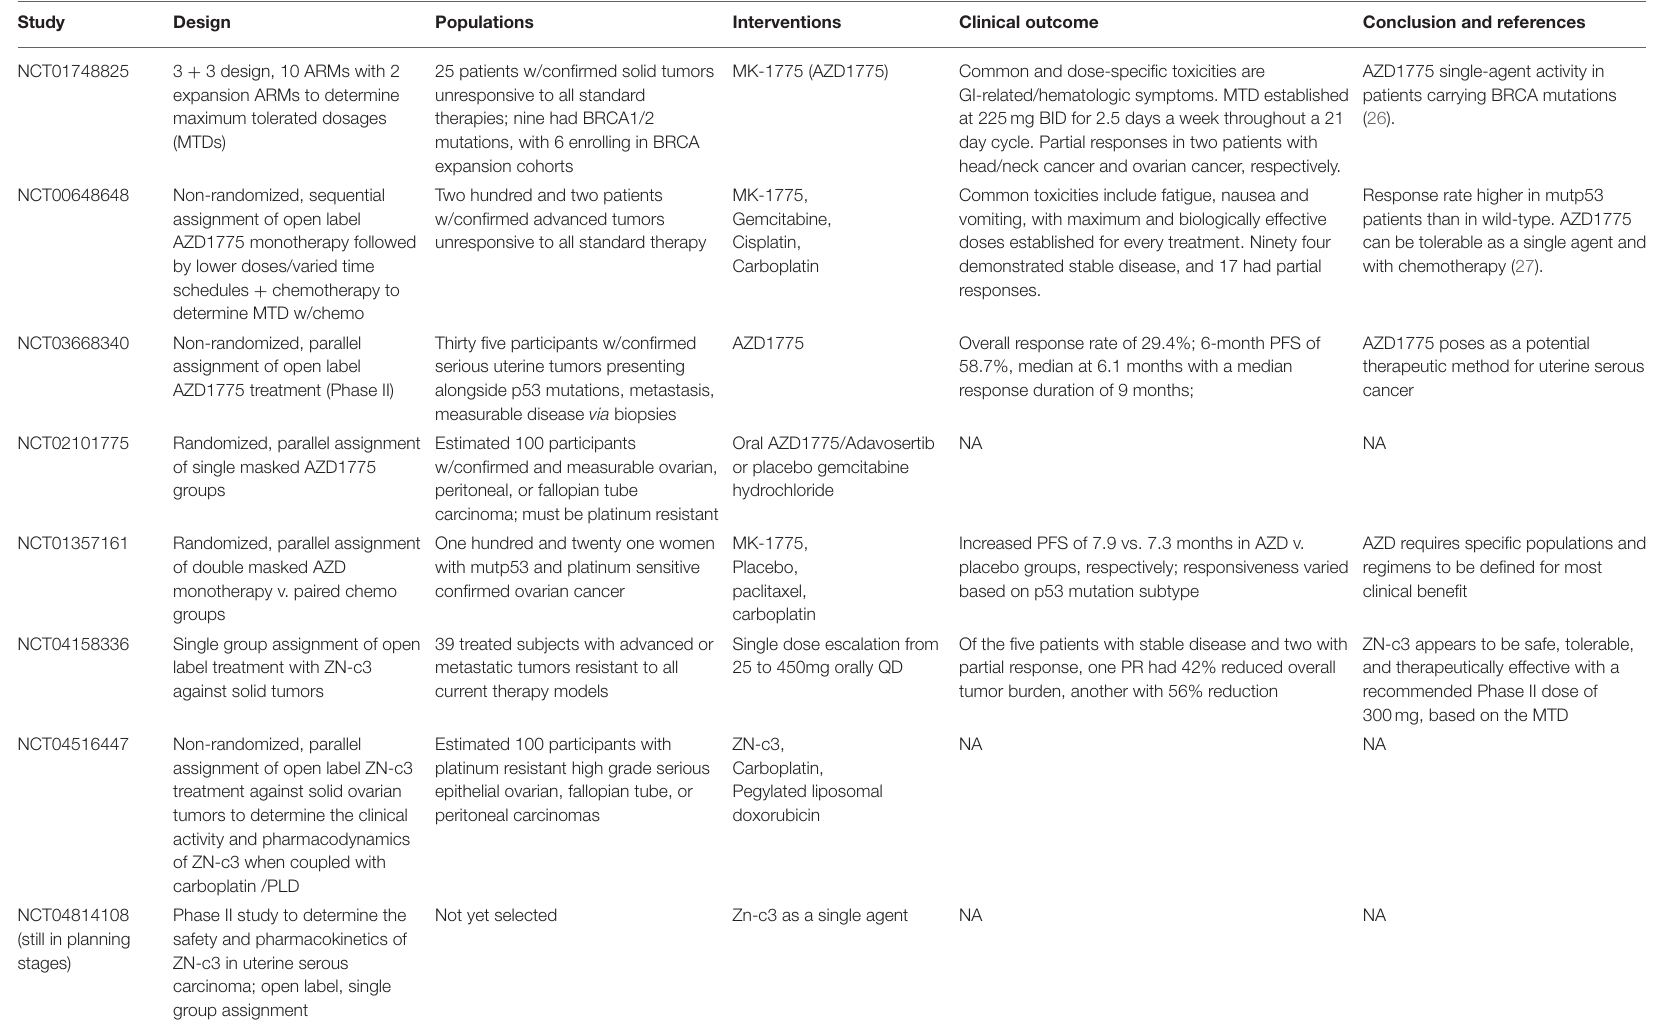
TABLE 2 | Summary of listed clinical trials for Wee1 inhibitors and statins.